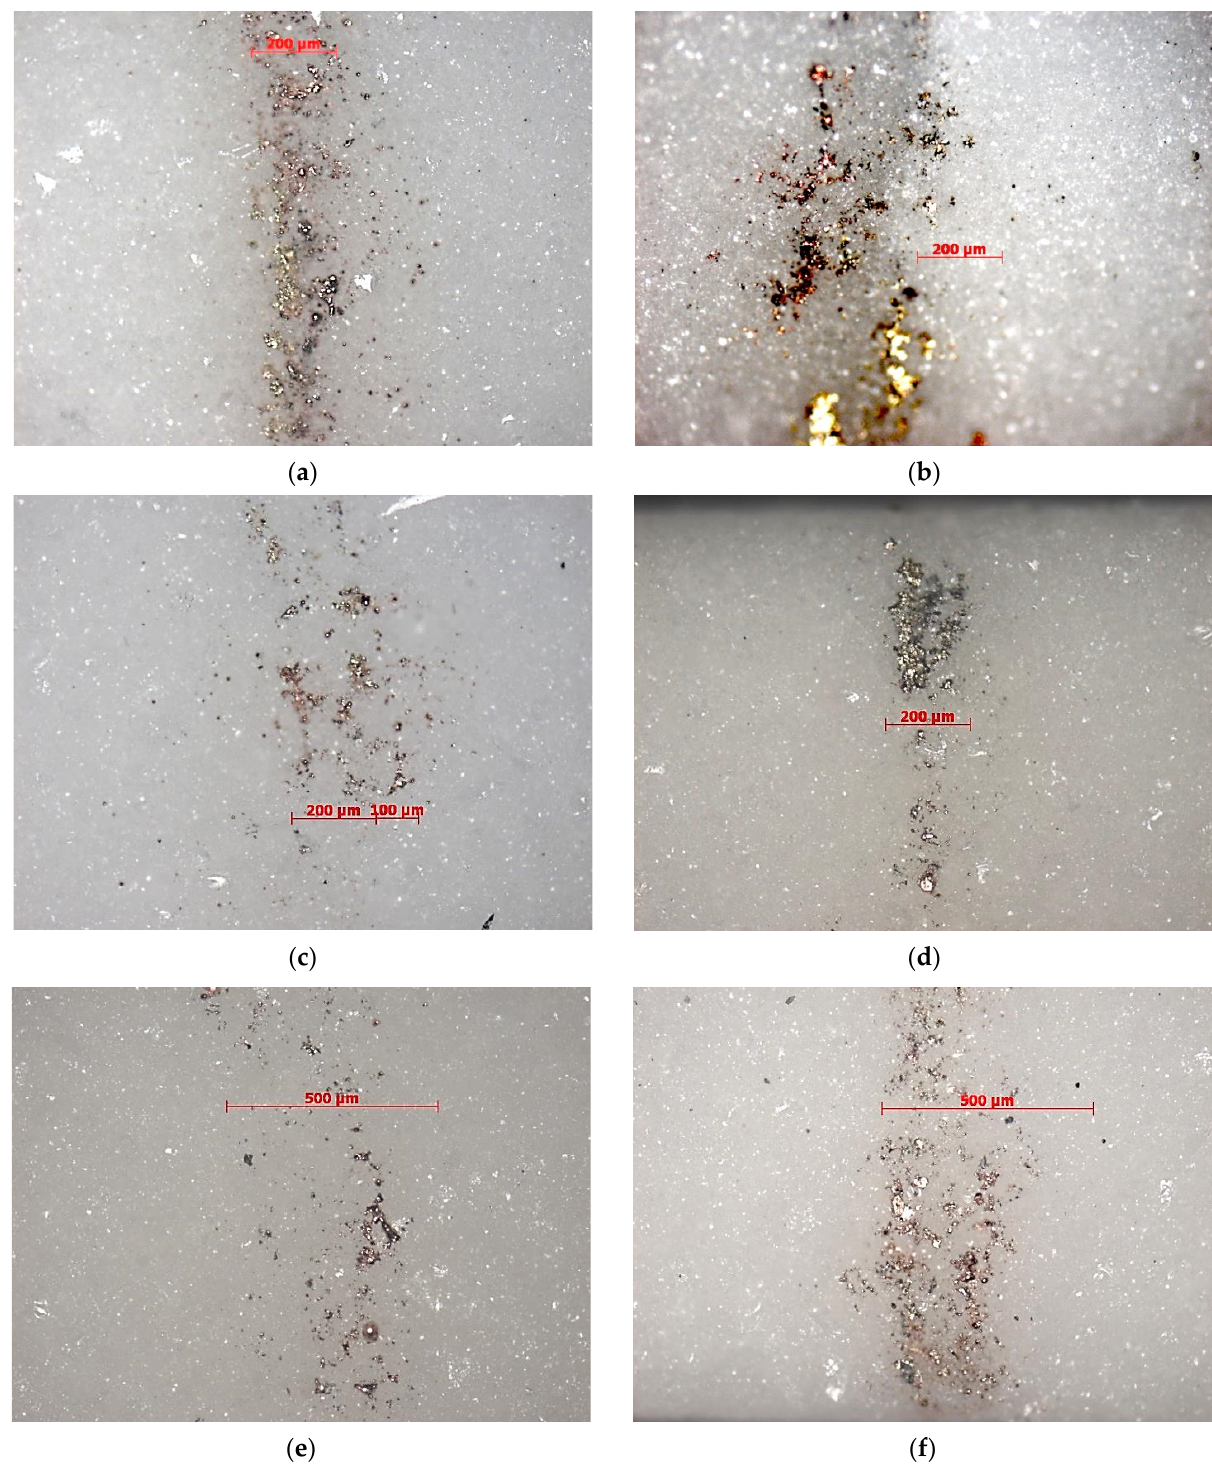
Figure 7. Optical microscopy of the obtained kerf in Al ₂ O ₃ samples coated with a double-layer copper tape coating of 80 µm (general view): ( a ) concentration of 7 g/L, pulse frequency f = 5 kHz, pulse duration D = 1.0 µs; ( b ) concentration of 14 g/L, pulse frequency f = 5 kHz, pulse duration D = 1.0 µs; ( c ) concentration of 21 g/L, pulse frequency f = 5 kHz, pulse duration D = 0.5 µs; ( d ) concentration of 35 g/L, pulse frequency f = 5 kHz, pulse duration D = 1.0 µs; ( e ) concentration of 50 g/L, pulse frequency f = 5 kHz, pulse duration D = 1.0 µs; ( f ) concentration of 100 g/L, pulse frequency f = 7 kHz, pulse duration D = 1.0 µs.